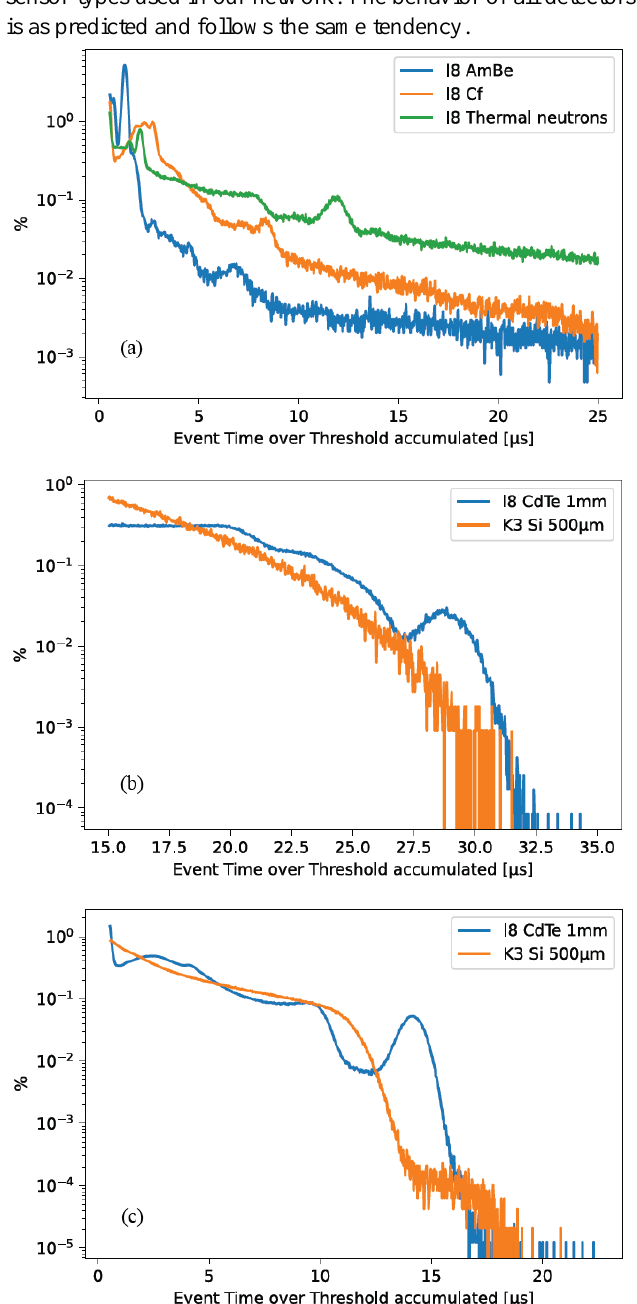
Fig. 5. Time over Threshold spectra of (a) three calibration neutron sources in the CdTe detector, (b) 60 Co in the CdTe and Si detectors, and (c) 137 Cs in the CdTe and Si detectors.